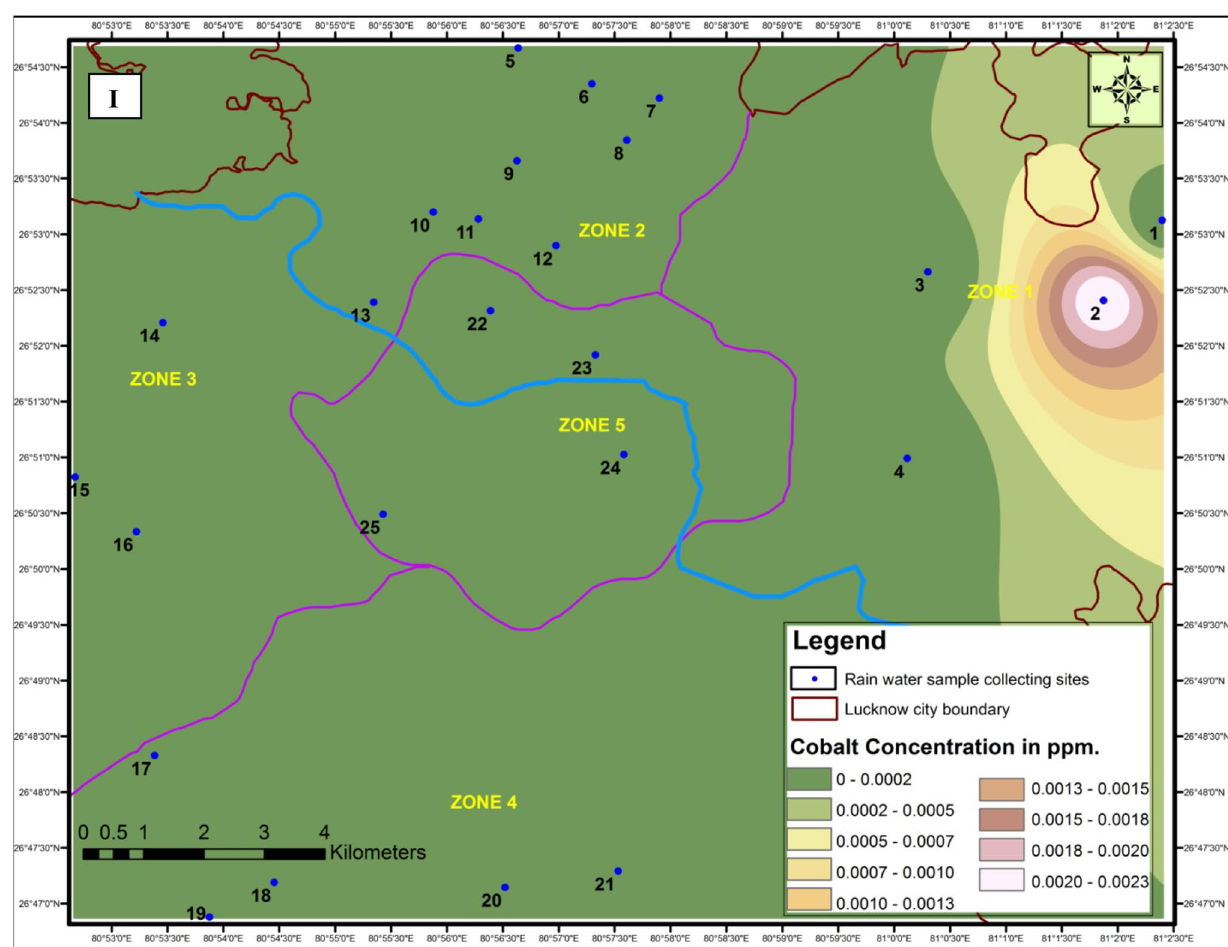
Fig. 10 Contour map of cobalt values at five zones of Lucknow city during first (I)